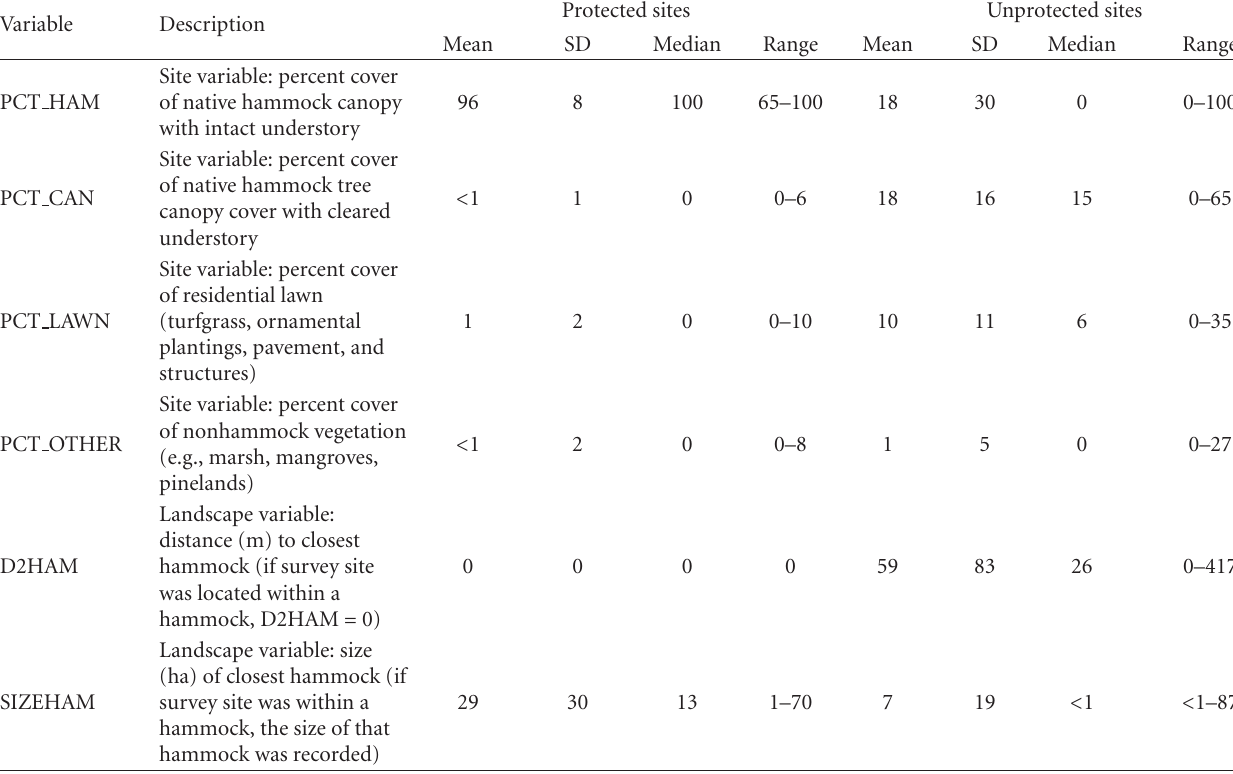
Table 1: Description and quantification (mean and standard deviation, median and range) of site and landscape variables at protected and residential sites where bird surveys were conducted (20-m fixed radius point counts) in the Florida Keys during March–May 2004 and 2005.